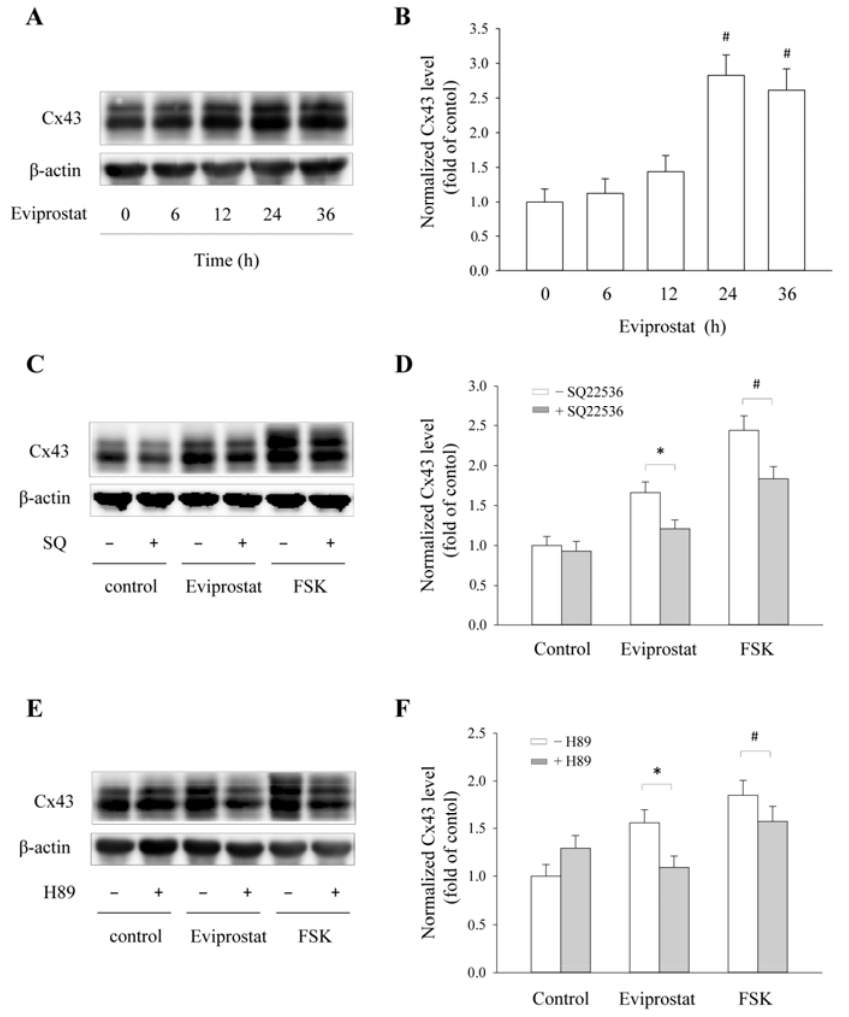
Figure 3. Induction of Cx43 expression by Eviprostat. ( A and B ) Upregulation of Cx43 induced by Eviprostat. Mesangial cells were incubated with 50 μ g/mL Eviprostat or 0.1% dimethylsulfoxide as vehicle control for indicated duration. The levels of Cx43 and β -actin were determined by Western blot analysis. Densitometric analysis of Cx43 expression were shown in B (mean ± SE, n = 4), # p < 0.01 vs. control. ( C – F ) Inhibition of adenylyl cyclase (AC) and PKA inhibitors on Cx43 levels induced by Eviprostat. Mesangial cells were pretreated to 50 μ M AC inhibitor SQ22536 or 10 μ M H89 for 30 min before exposing to 50 μ g/mL Eviprostat or 10 μ M FSK for 24 h in the continuous presence of the inhibitors. Densitometric analysis of Cx43 expression of C and E were shown in D and F , respectively. The results were normalized to corresponding β -actin level, and data were presented as relative induction against the basal level. # p < 0.01, * p <